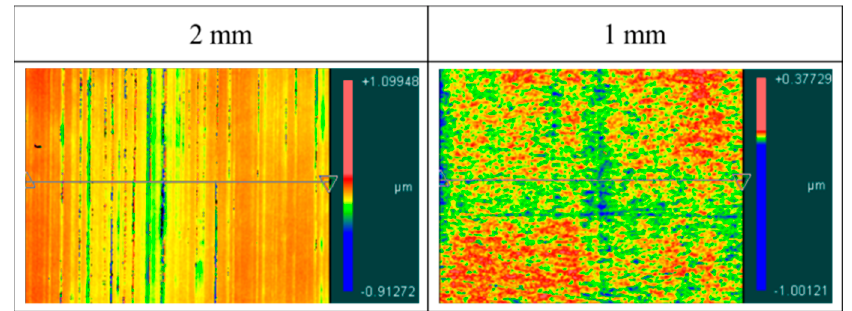
Figure 9. Macroscopic confocal images of the finished surface under the conditions of various working gaps after the 60-min MAF process.